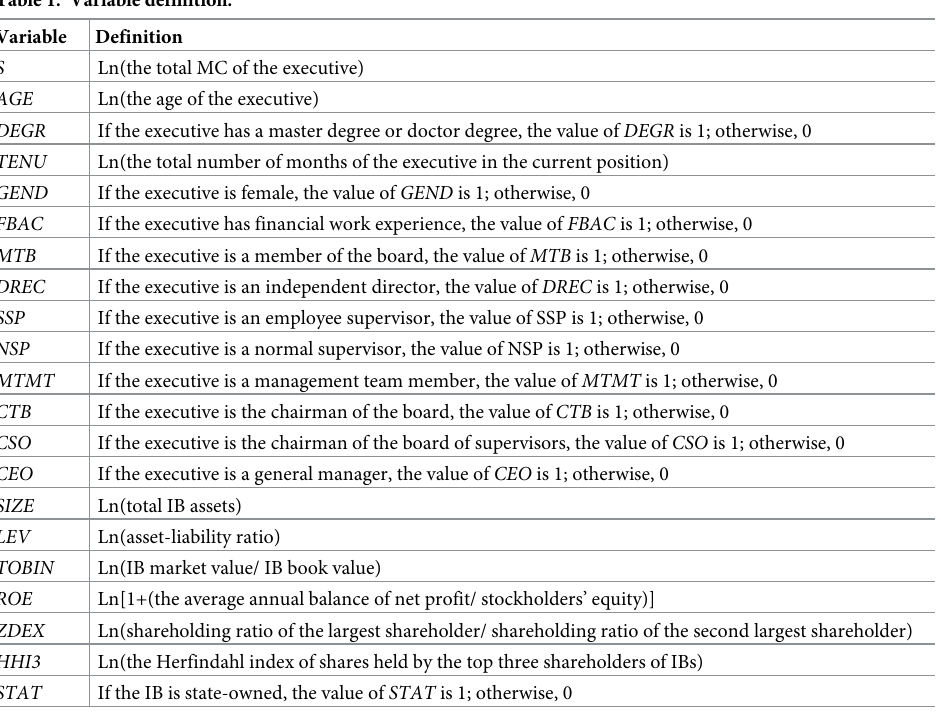
Table 1. Variable